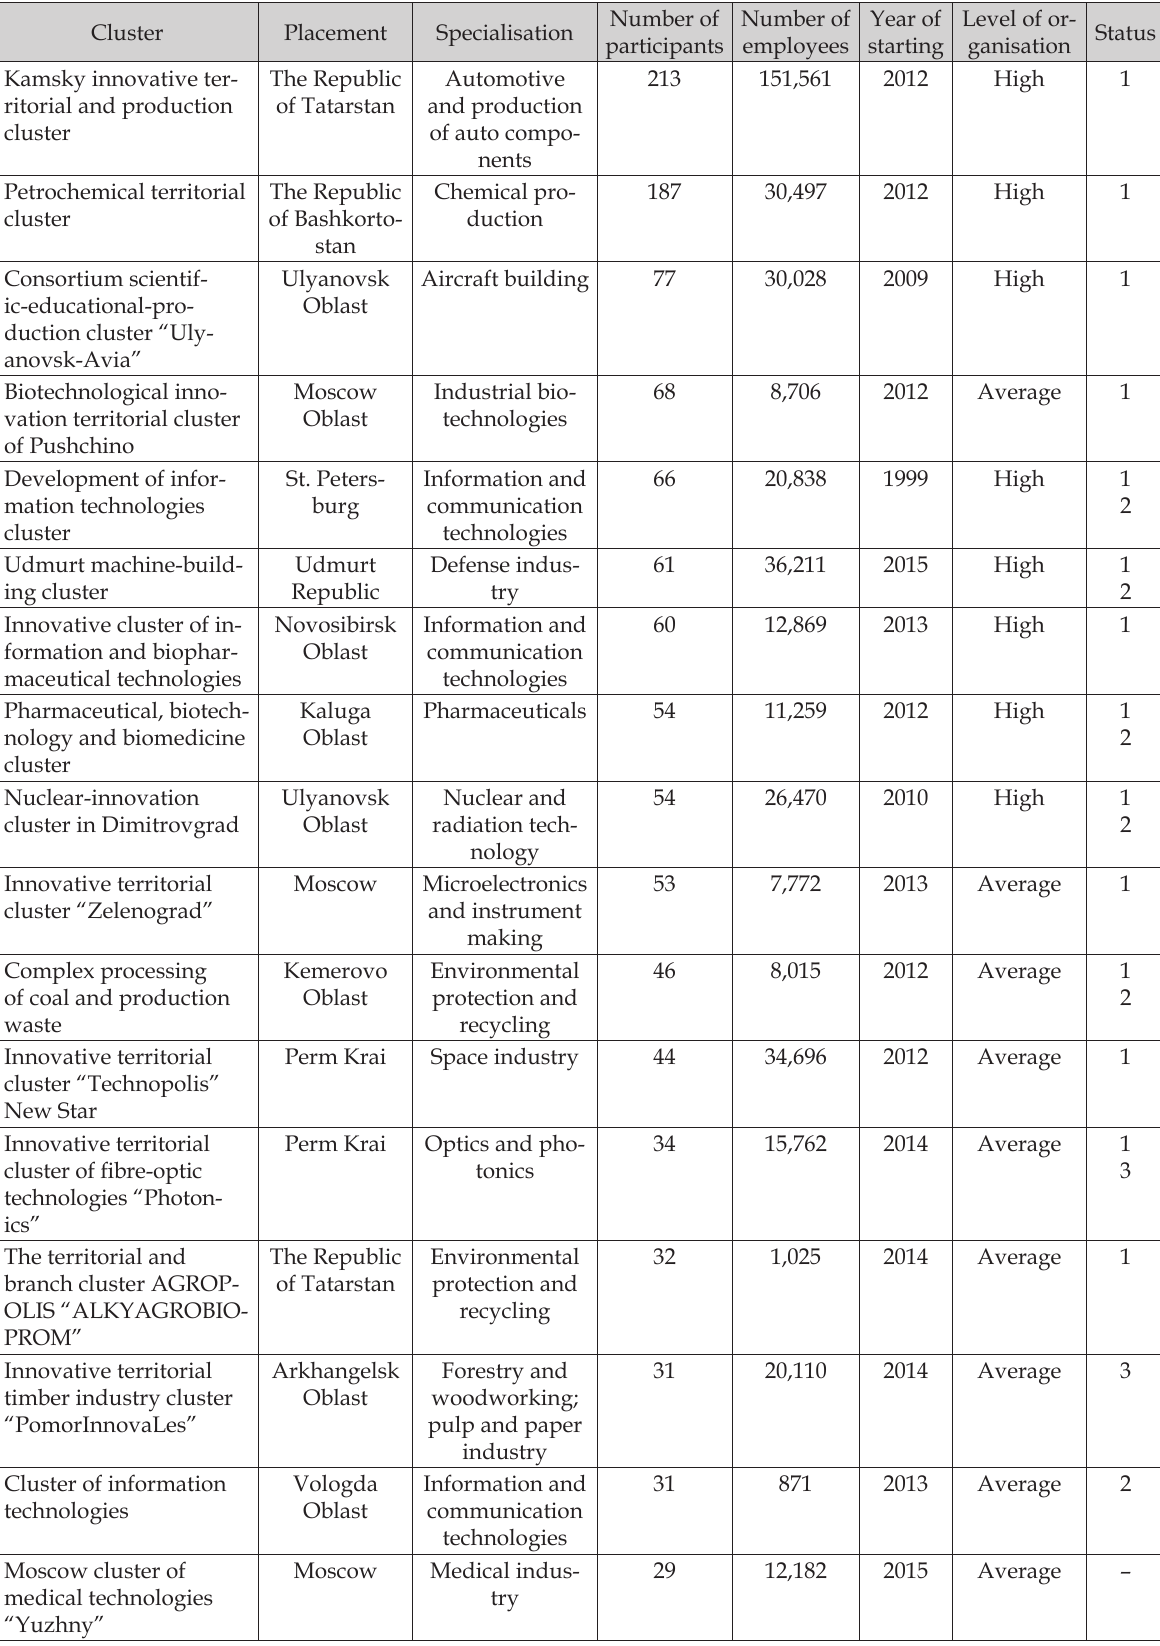
Table 3. Selected data for clusters of the high and middle organisational level in the Russian Federation.